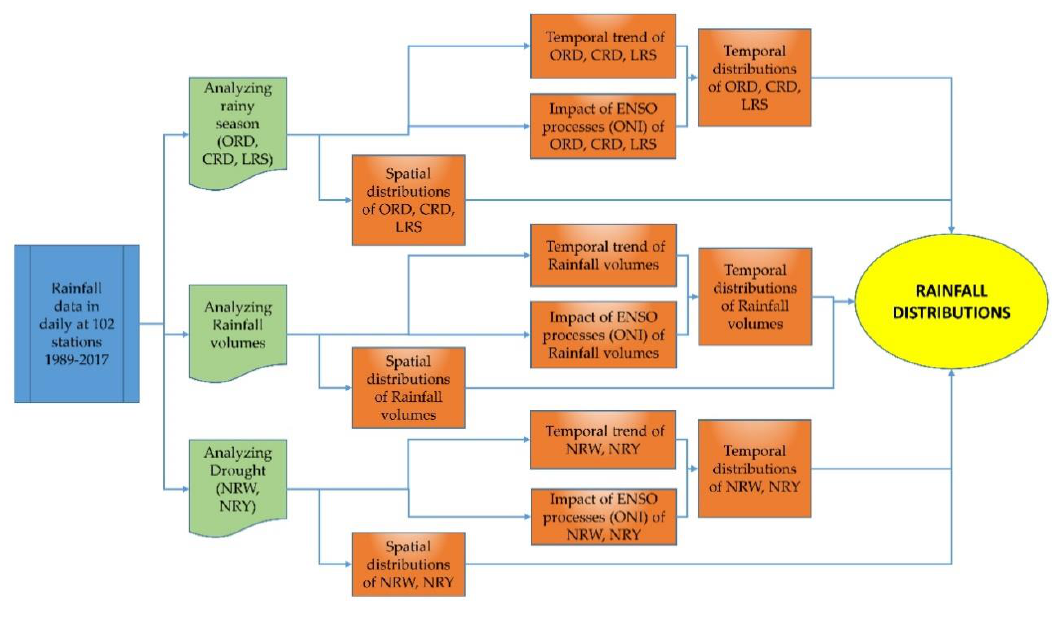
Figure 2. Methodology flowchart.